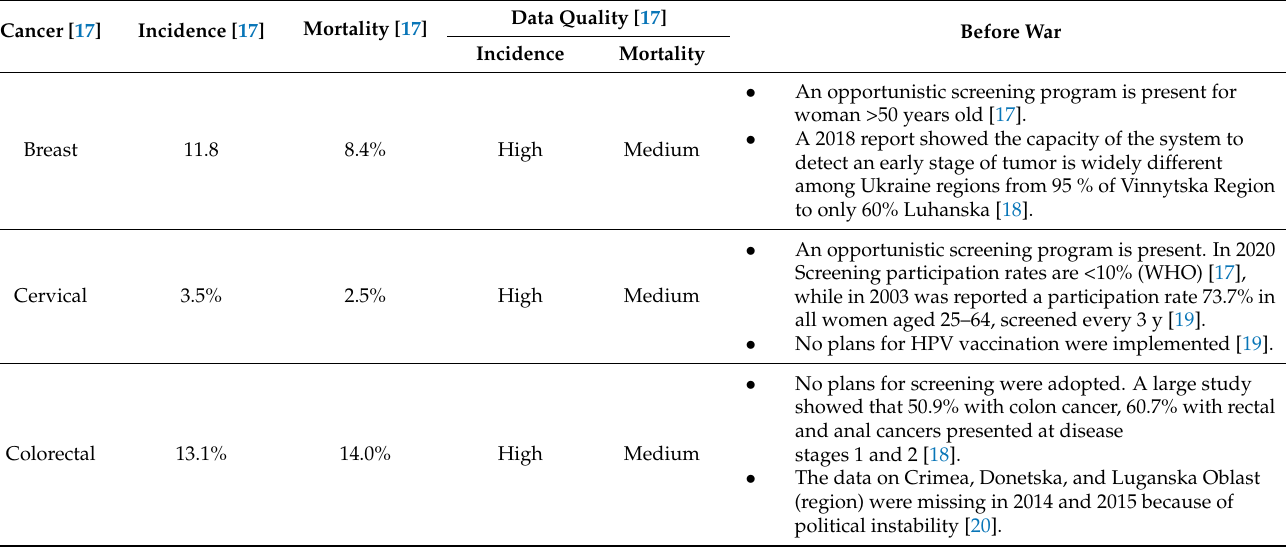
Table 1. Situation on cancers early detection program in Ukraine before the 2022